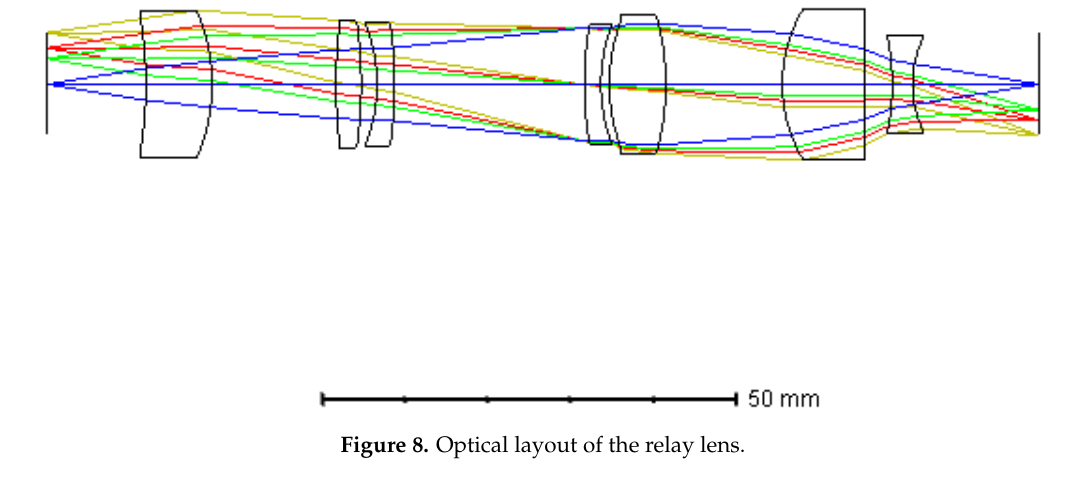
Figure 8. Optical layout of the relay lens.